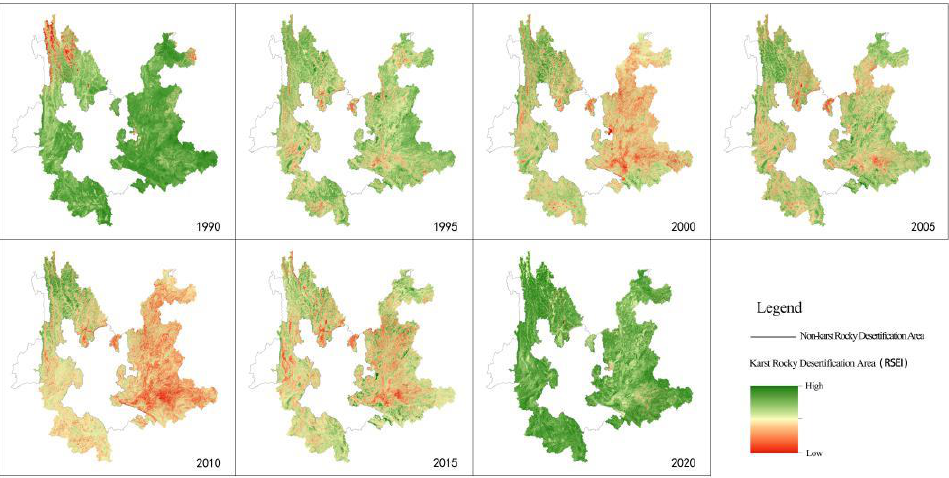
Figure 3. Dynamic evolution characteristics of RSEI in Yunnan karst rocky desertification areas (1990 –